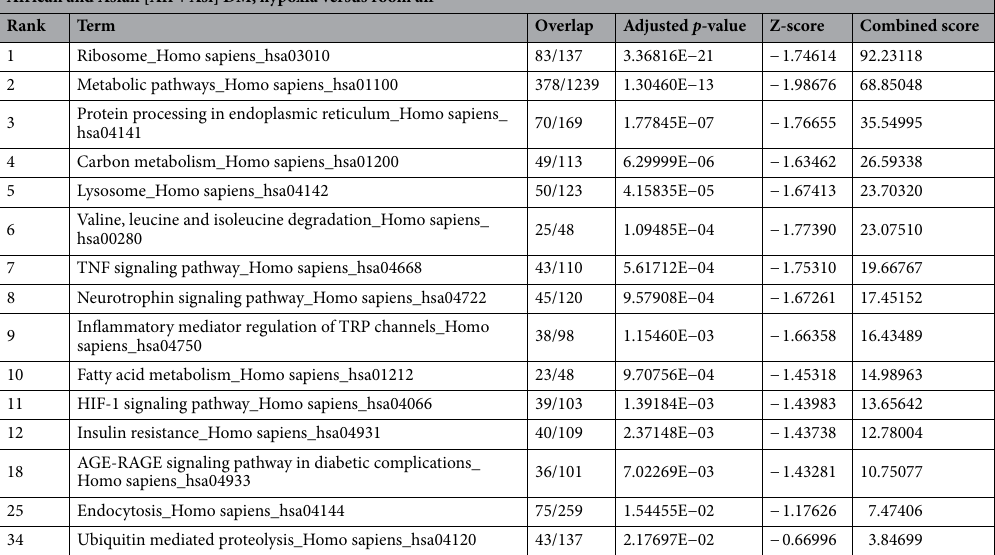
Table 1. EnrichR Pathway analysis of differentially-expressed genes between Afr + Asi/DM cybrids cultured in room air versus 2% oxygen. The top 10 pathways, along with others that are much more differently ranked between the Euro/DM and [Afr + Asi]/DM comparisons are